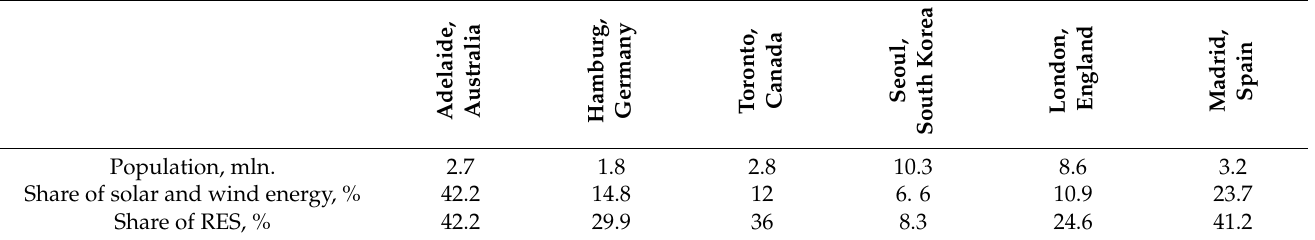
Table 2. Analytical data: population (million people), share of solar and wind energy (%), share of renewable energy (%), by city.